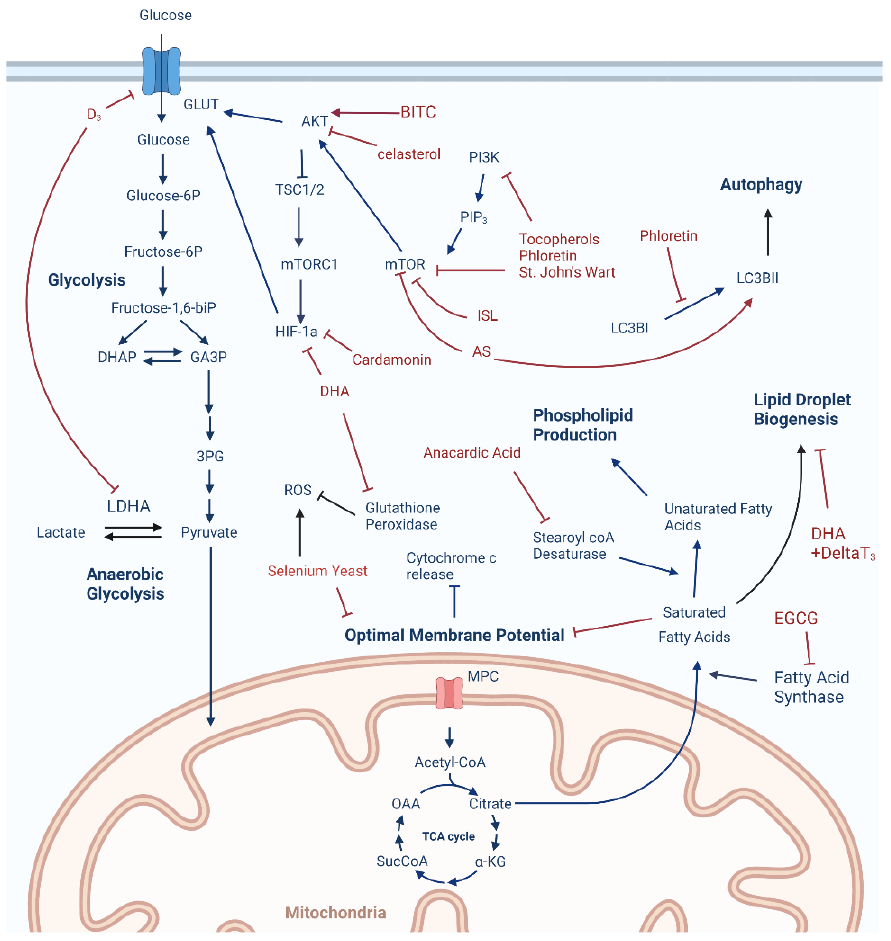
Figure 1. Metabolic targets of nutrients and nutraceuticals in TNBC cells. Akt, protein kinase B; AS, Antrodia Salmonea, BITC, benzyl isothiocyanate; D 3 , vitamin D 3 (calcitriol); Delta T 3 , vitamin E delta-tocotrienol; DHA, docosahexaenoic acid; DHAP, dihydroxyacetone phosphate; EGCG, epigallocatechin gallate; GA3P, glyceraldehyde-3-phosphate; GLUT, glucose transporter; HIF-1a, hypoxia inducible factor 1 alpha; ISL, isoliquiritigenin; LDHA, lactate dehydrogenase A; MPC, mitochondrial pyruvate carrier; mTOR, mammalian target of rapamycin; mTORC1, mammalian target of rapamycin complex 1; OAA, oxaloacetate; PI3K, phosphoinositide 3-kinase; PIP 3 , phosphatidylinositol (3,4,5)-trisphosphate; ROS, reactive oxygen species; SucCoA, succinyl-coenzyme A; TSC1/II, Tuberous sclerosis I/II; 3PG, 3-phosphoglycerate; α -KG, alpha ketoglutarate.